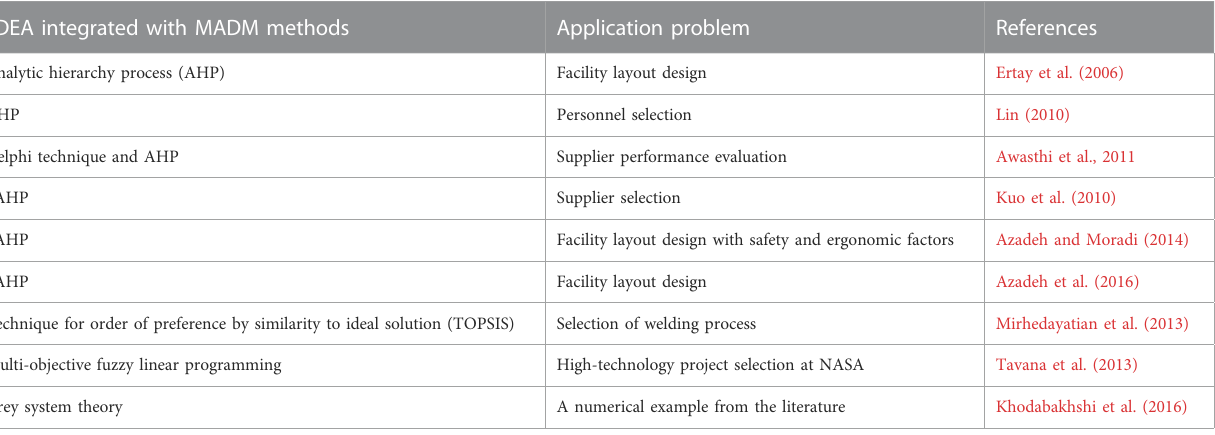
TABLE 2 The review on FDEA integrated with MCDM